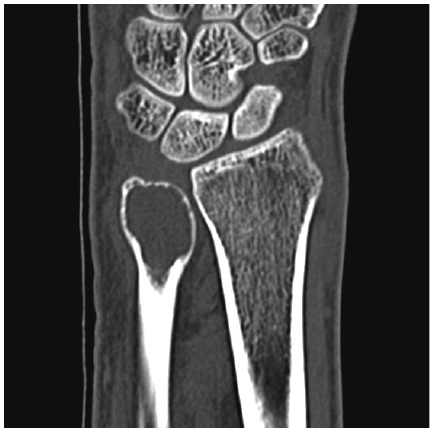
Figure 2: Computed tomogram showed thinning and protrusion of the cortex but no destruction of the cortex of the distal ulna.